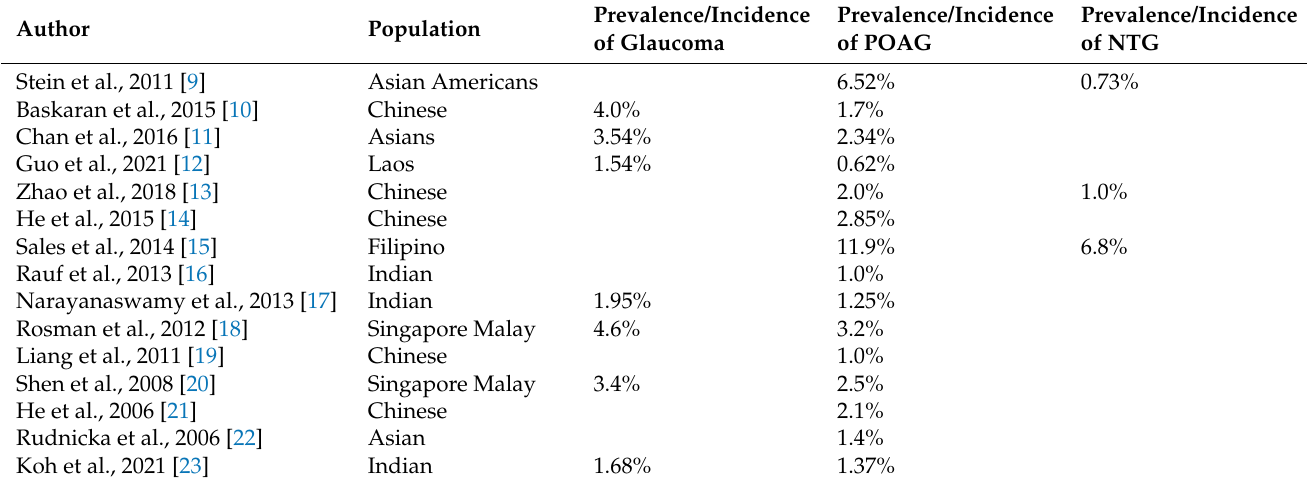
Table 1. Prevalence and Incidence of Glaucoma in Asian Populations. POAG: Primary open-angle glaucoma; NTG: normal-tension